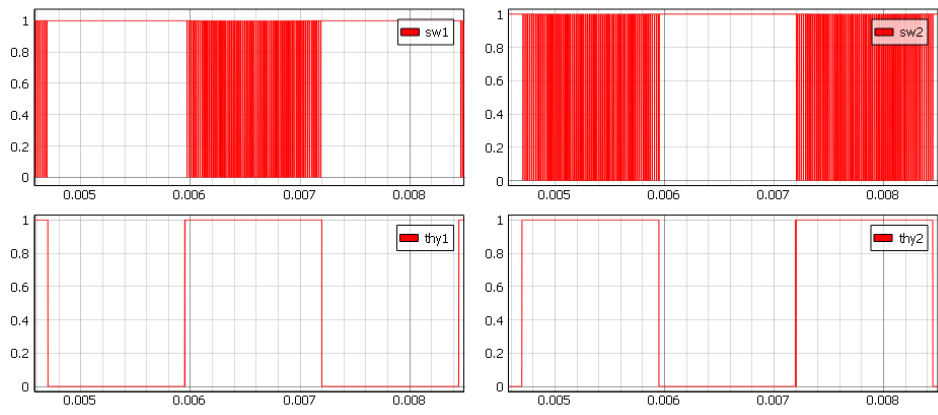
Figure 14. The WS and SCR switching signals